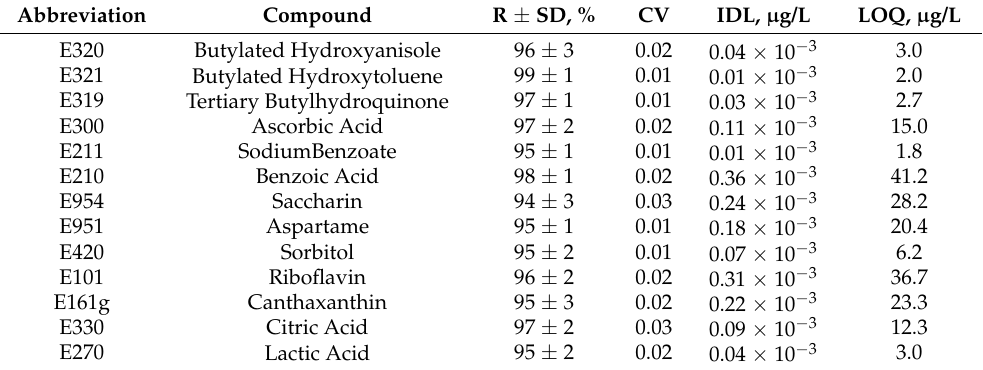
Table 5. Validation parameters of the method used for the targeted chromatographic